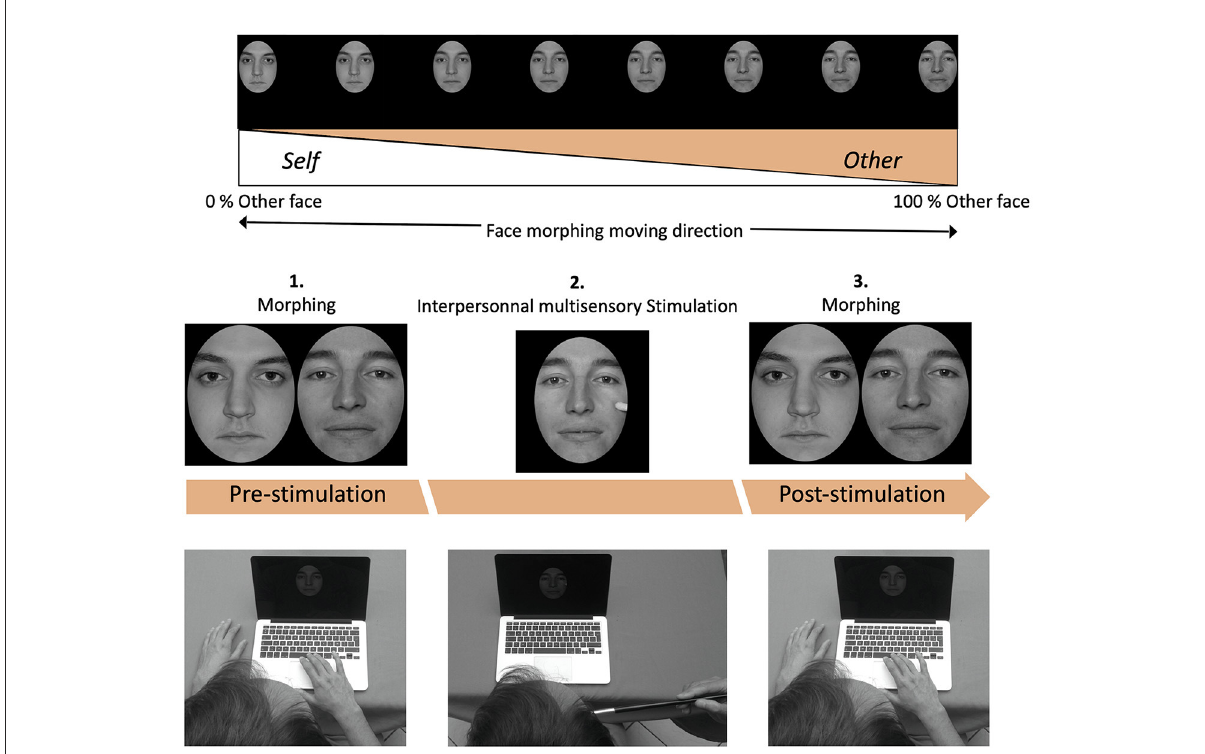
FIGURE1 Experimental set-up of the self-recognition task with the two different morphing directions of the movies: from “self to other” (movie started from self-image and ended with other-image, or from “other to self” movie started from other-image and ended with self-image); Design of the experimental blocks containing three phases: pre-stimulation test, visual-tactile stimulation and post-stimulation test.